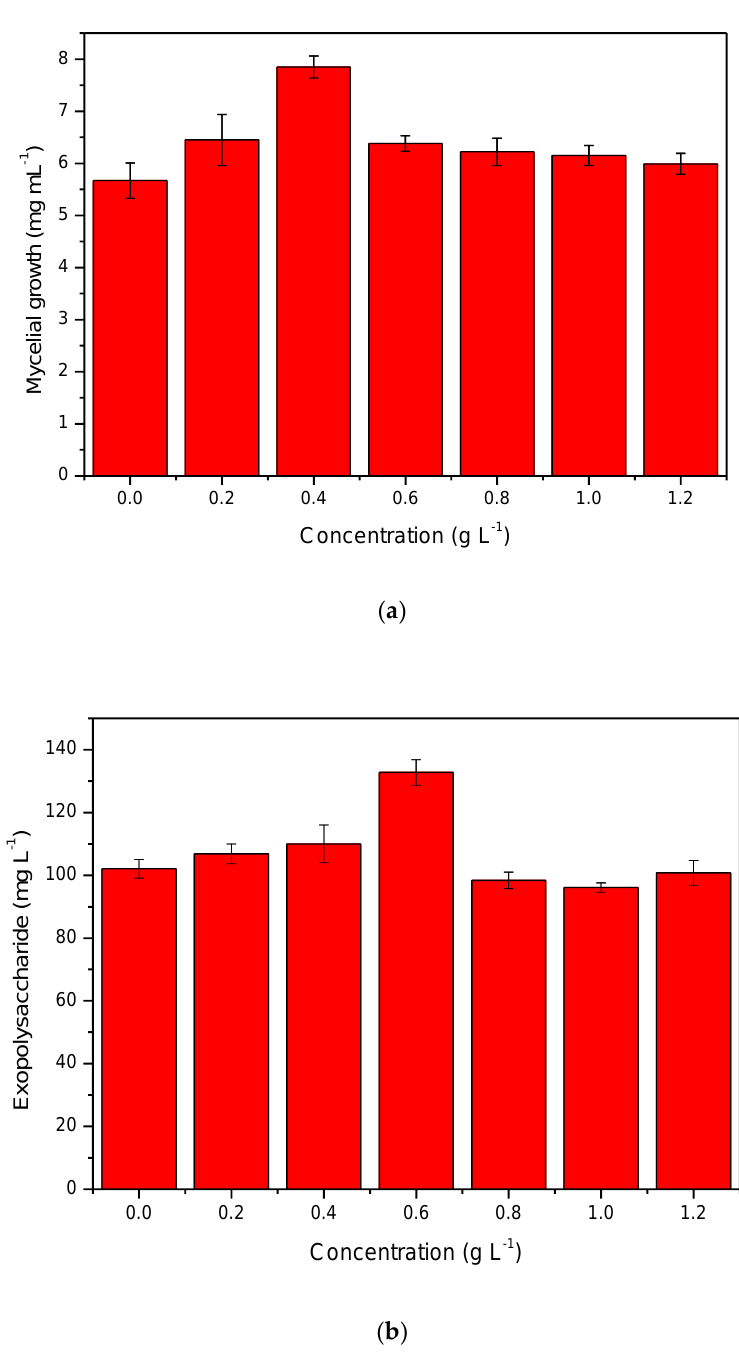
Figure 2. The effects of different Tween 80 concentrations on mycelia growth ( a ) and EPS production ( b ) in shake − flask cultures.